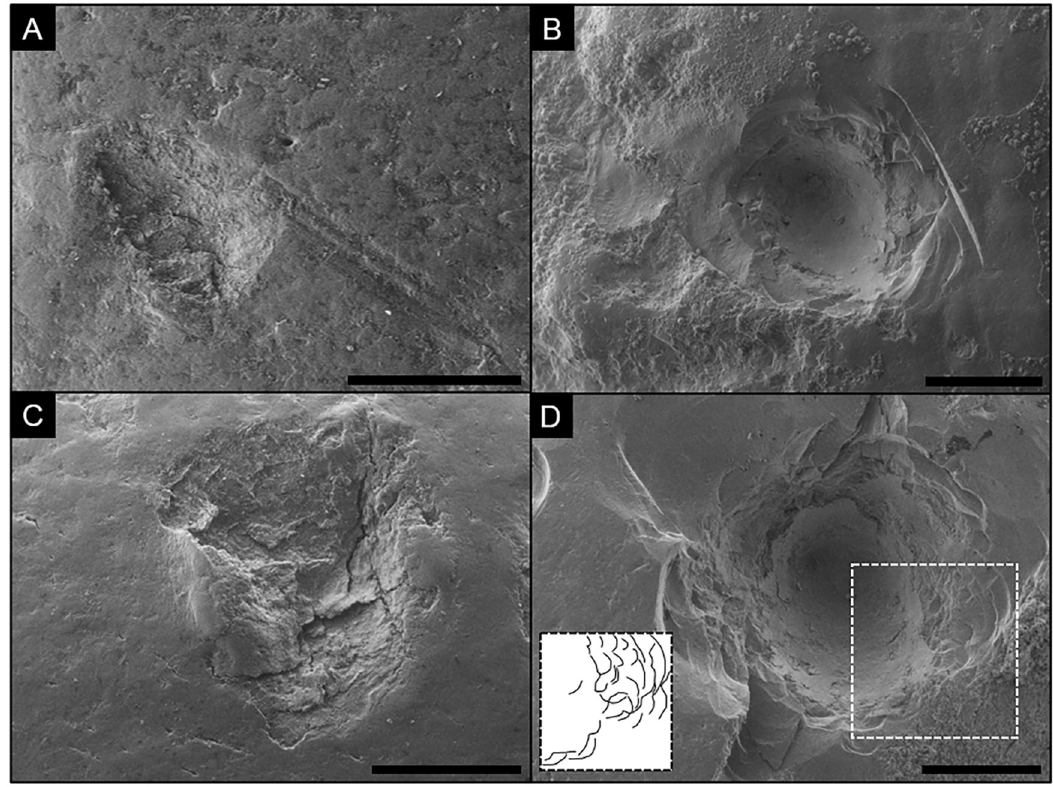
Fig 3. Comparison of carnivore-induced tooth pits (left column) and air-scribe-induced pits (right column) under SEM. Notice the rosette-like morphology of the pits depicted on the right. A) Shallow tooth pit with associated microgrooves (faint score) on a bovid long bone; scale bar = 1.0 mm. B) Shallow pit generated by an air-scribe on a fossilized mammalian bone fragment. Notice the sequential, stepwise scalloping that creates flat benches on the various layers of cortical lamellae; scale bar = 1.0 mm. C) tooth pit with raised margins on the left and right sides; scale bar = 1.0 mm. D) Somewhat deeper air-scribe-induced pit (relative to B) on a mammalian fragment; scale bar = 1.0 mm. Inset is interpretive drawing of highlighted